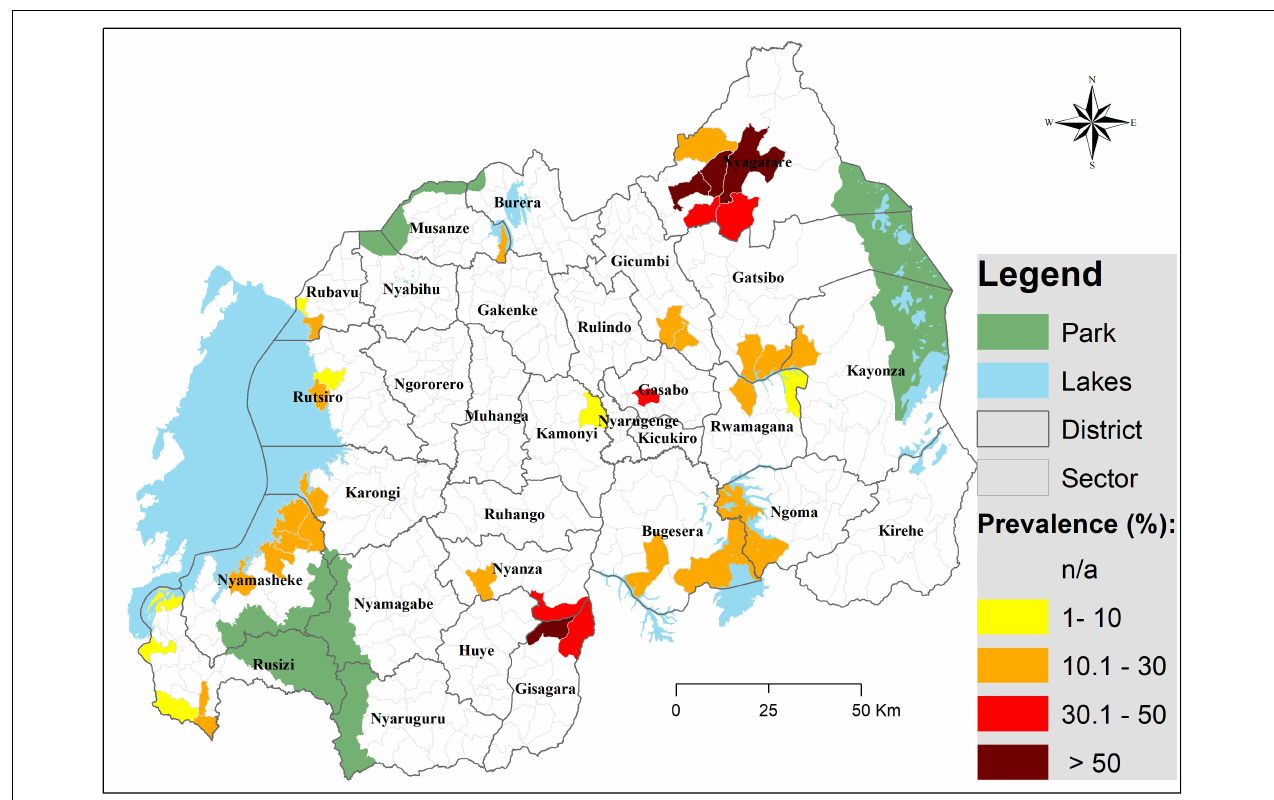
FIGURE 1 | A map illustrating the distribution of Schistosoma mansoni infection among pre-SAC in Rwanda. Infection prevalence was based on CCA findings (trace as negative); geographical coordinates were collected for each site (village) and were extrapolated to the lowest administrative boundary (sector).